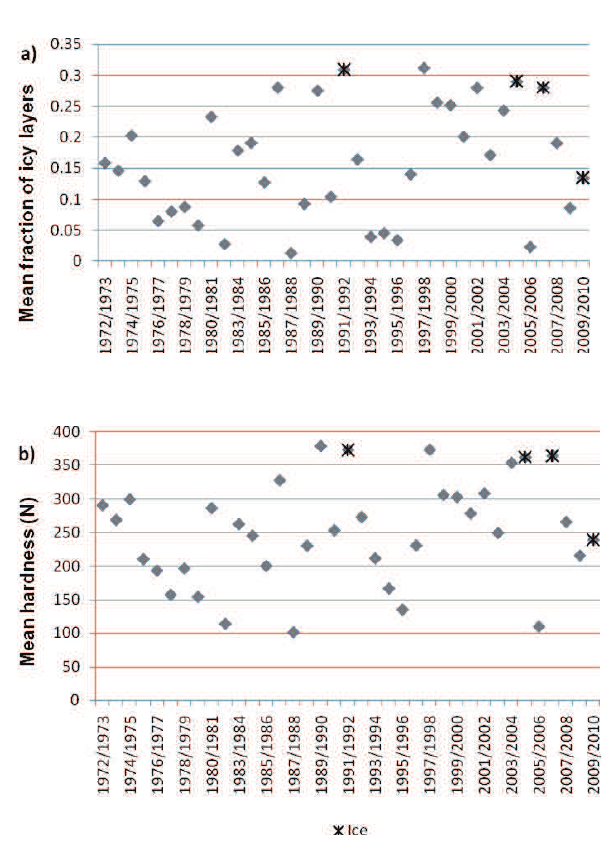
Figur e 7. The simulated mean fraction of icy layers (a) and hard- ness of the snow cover (b) during winters 1972-2010. Winters with icy conditions reported by the reindeer herders marked with stars.